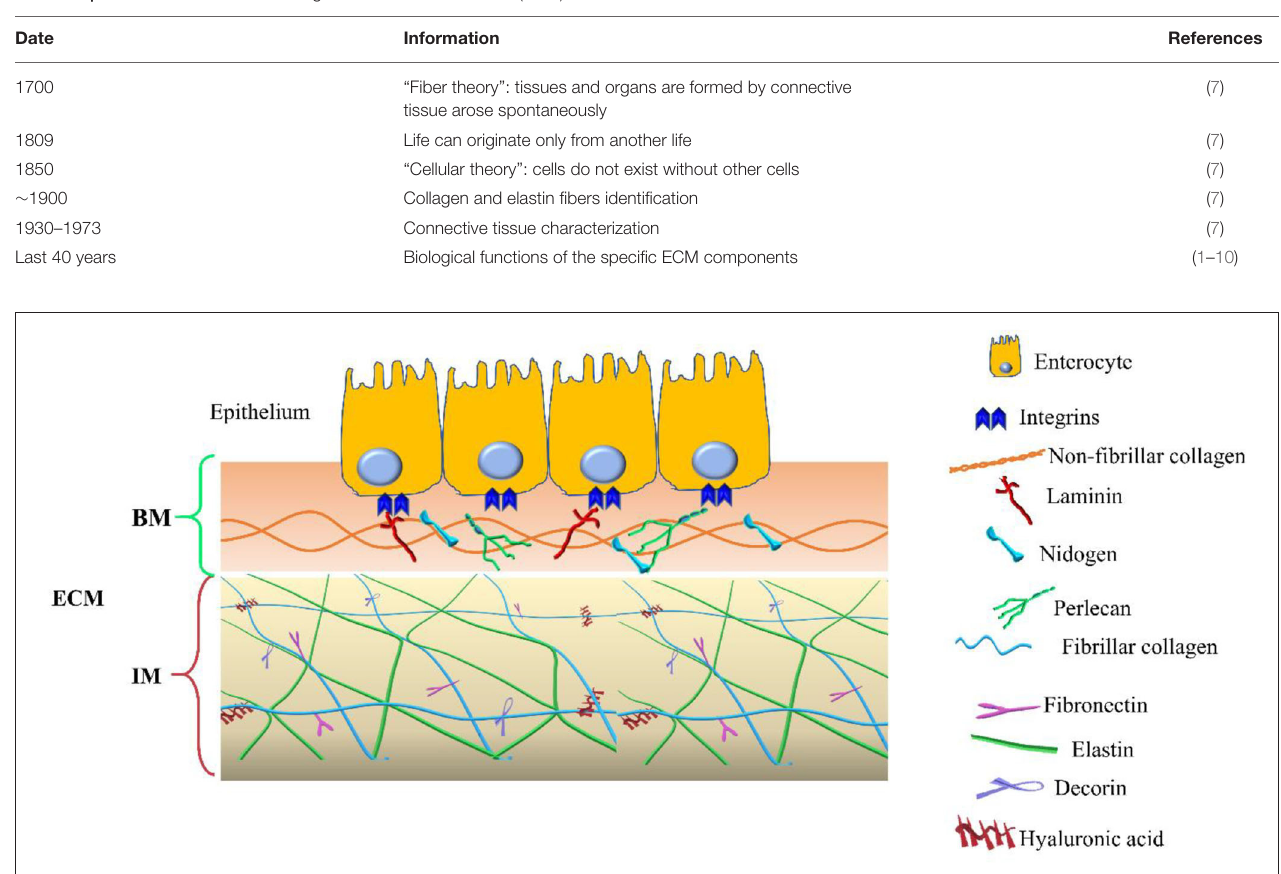
FIGURE 1 | Extracellular matrix (ECM) compartments. Schematic representation of the main components of the two ECM compartments: basement membrane (BM) and interstitial matrix (IM). The legend indicates the identity of each ECM components.